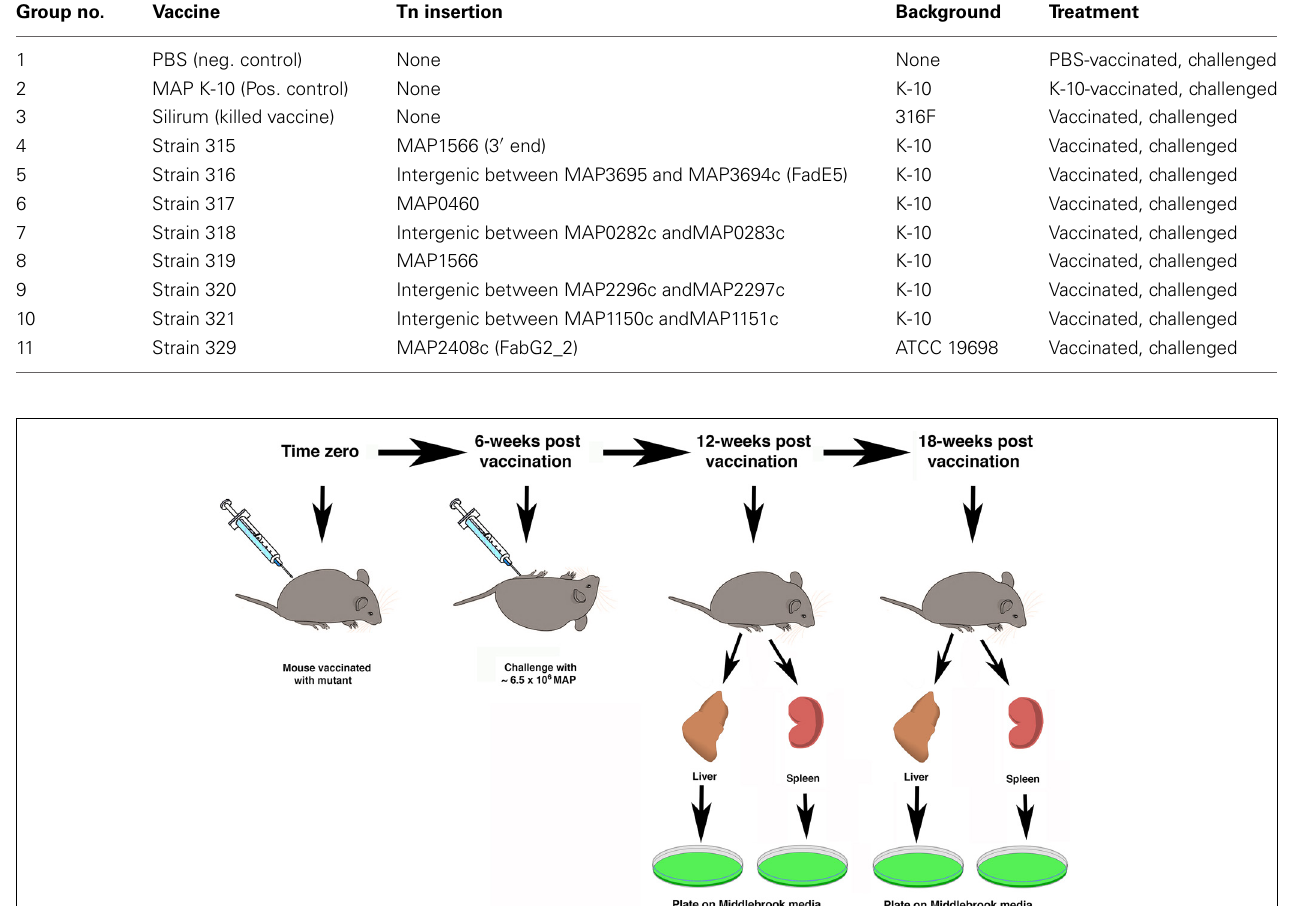
FIGURE 1 | Schematic overview of study design. The time scale at the top represents the weeks after vaccination. At time zero mice were immunized with attenuated mutant strains and controls. Mice were challenged by